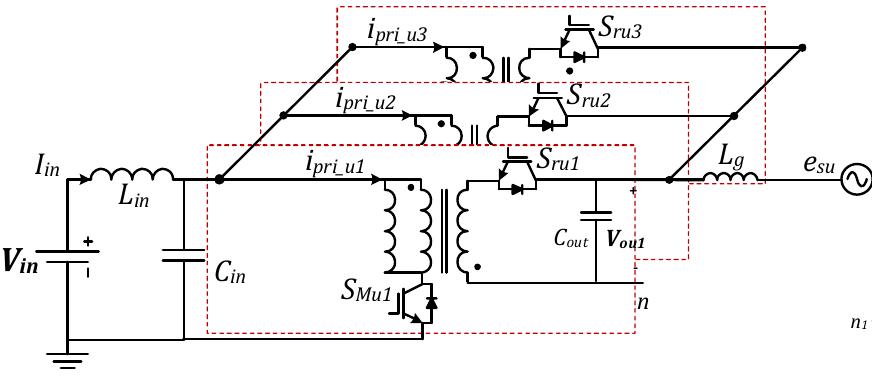
Figure 2. One phase of the proposed MFBDI, N = 3.